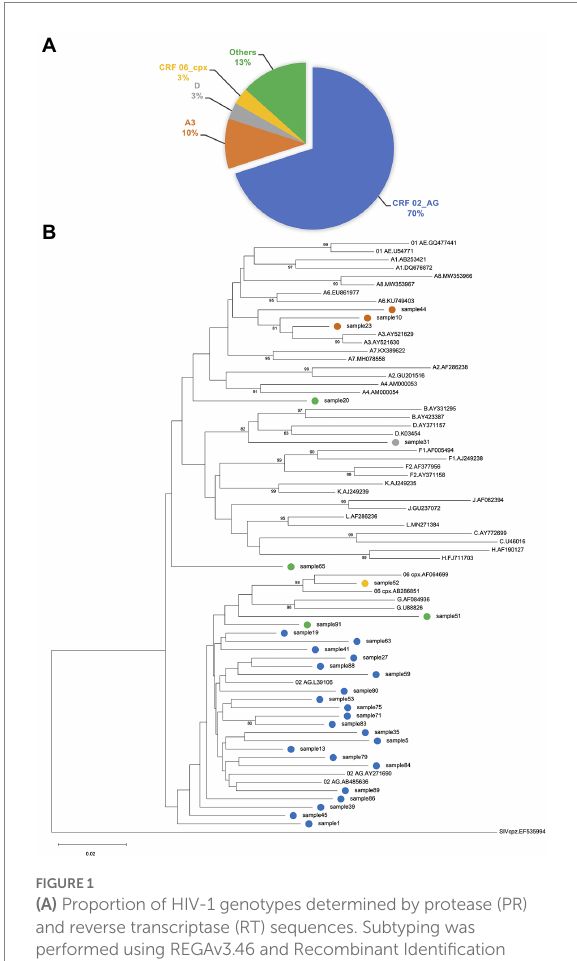
FIGURE 1 (A) Proportion of HIV-1 genotypes determined by protease (PR) and reverse transcriptase (RT) sequences. Subtyping was performed using REGAv3.46 and Recombinant Identification Program (RIP.v.3.0). The predominant subtype in this study was CRF02_AG (70%). Recombinants of A3 and G; A3 and CRF02_AG; A1 and G, as well as G and CRF02_AG are grouped as “Others.” (B) Phylogenetic inference of HIV-1 subtypes. Phylogenetic analysis of PR-RT sequences using neighbor-joining tree with the Molecular Evolutionary Genetic Analysis tool version 11 (MEGA11). Clustering pattern of study samples corroborates classification of samples by subtyping tools. Study samples are tagged with colored circles, indicating the various subtypes. References were obtained from the Los Alamos database (https://www.hiv.lanl. gov/components/sequence/HIV/). Labelling format of reference sequences = Subtype.Accession-number.